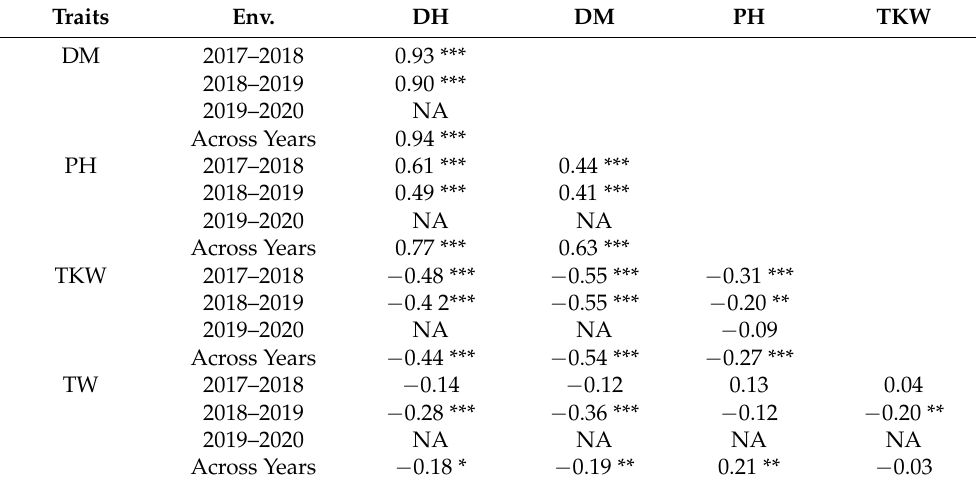
Traits Env. DH DM PH TKW